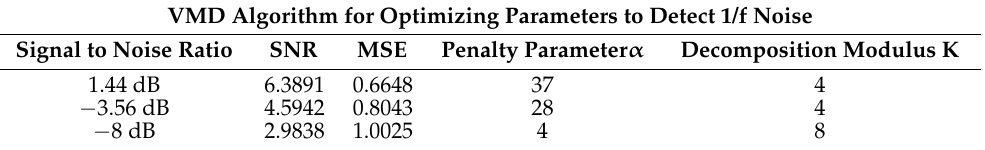
Table 3. VMD algorithm for optimizing parameters to detect 1/f noise. VMD Algorithm for Optimizing Parameters to Detect 1/f Noise